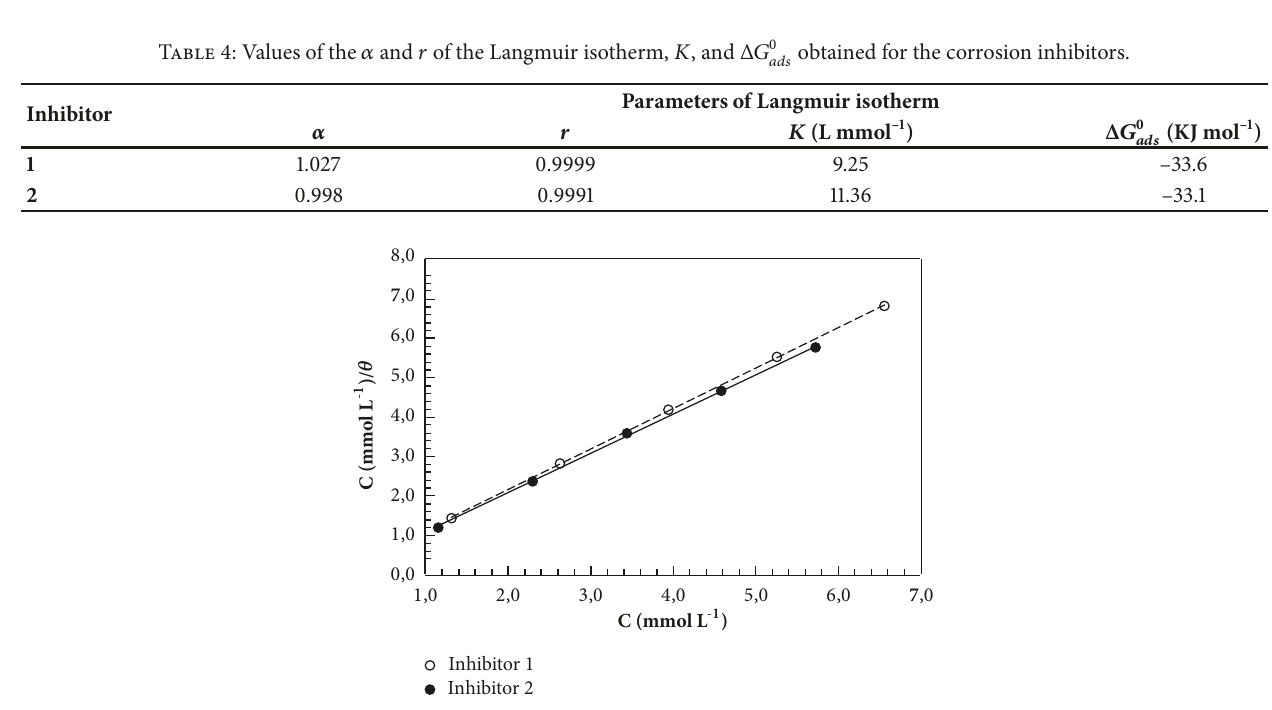
Figure 2: Langmuir adsorption isotherms of triazole compounds on the carbon steel surface in 1.0 mol L – 1 HCl aqueous